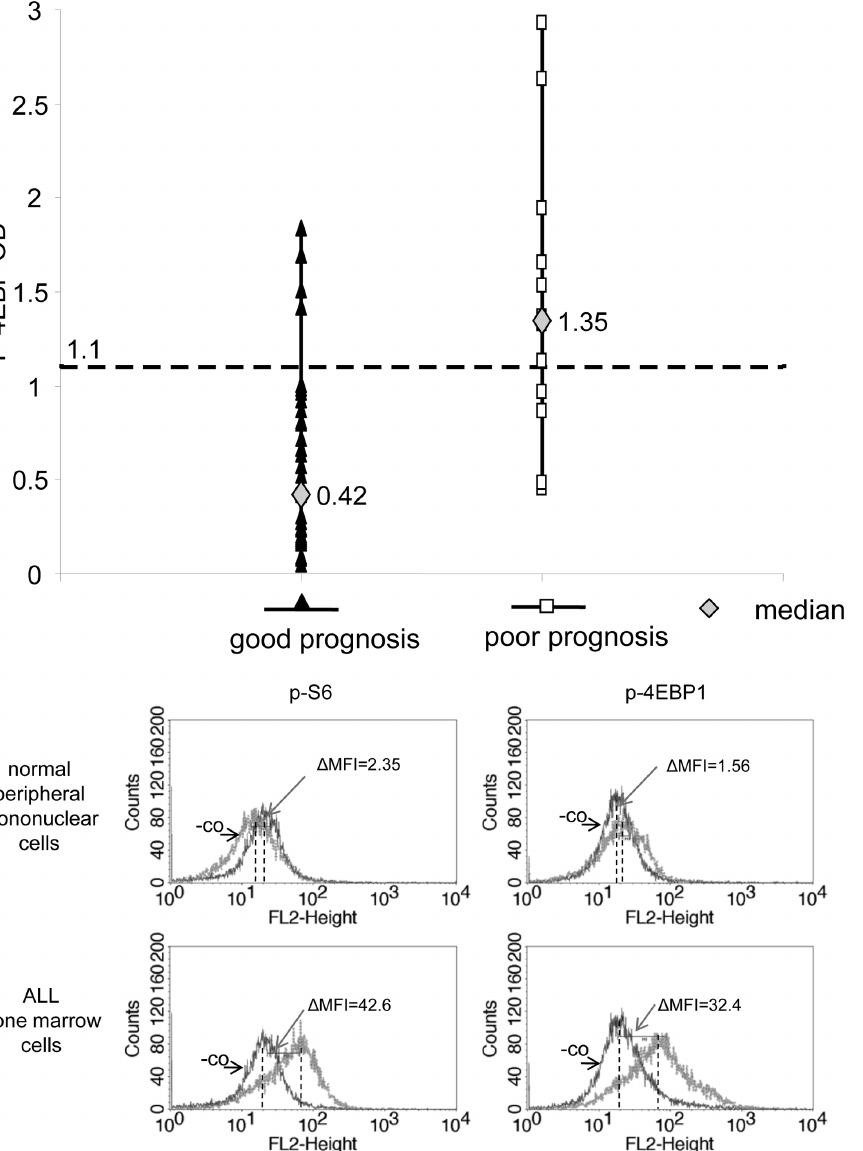
Figure 2. mTOR activity related p-4EBP1 expression in samples of ALL patients with different prognoses (ELISA) and detection of p- 4EBP1 and p-S6 in ALL cells by flow cytometry. (a) P-4EBP1 OD values in 49 ALL samples (n=37 for patients with good prognosis; n=12 for poor prognosis, criteria for prognostic groups are described in the Methods section). P-4EBP1 OD levels were significantly different between patients with good and poor prognosis (p , 0.05). The cutoff value between p-4EBP1 OD values representing high and low mTOR activity was determined to be 1.1 by ROC curve analysis. (b) p-S6 and p-4EBP1 overexpression is confirmed by flow cytometry in ALL cells. Representative histograms for p-4EBP1 and p-S6 flow cytometric analysis in normal PMNC and in ALL samples. Expression was calculated as the difference between MFIs of p-4EBP1 or p-S6 stained (p-4EBP1 and p-S6, respectively) and parallel unstained controls (-co). Differences between MFIs ( D MFI) was 2.35 (pS6) and 1.56 (p-4EBP1) for normal peripheral mononuclear cells. However, D MFI was 42.6 and 32.4 for p-S6 and p-4EBP1, respectively, in the representative ALL case shown here.